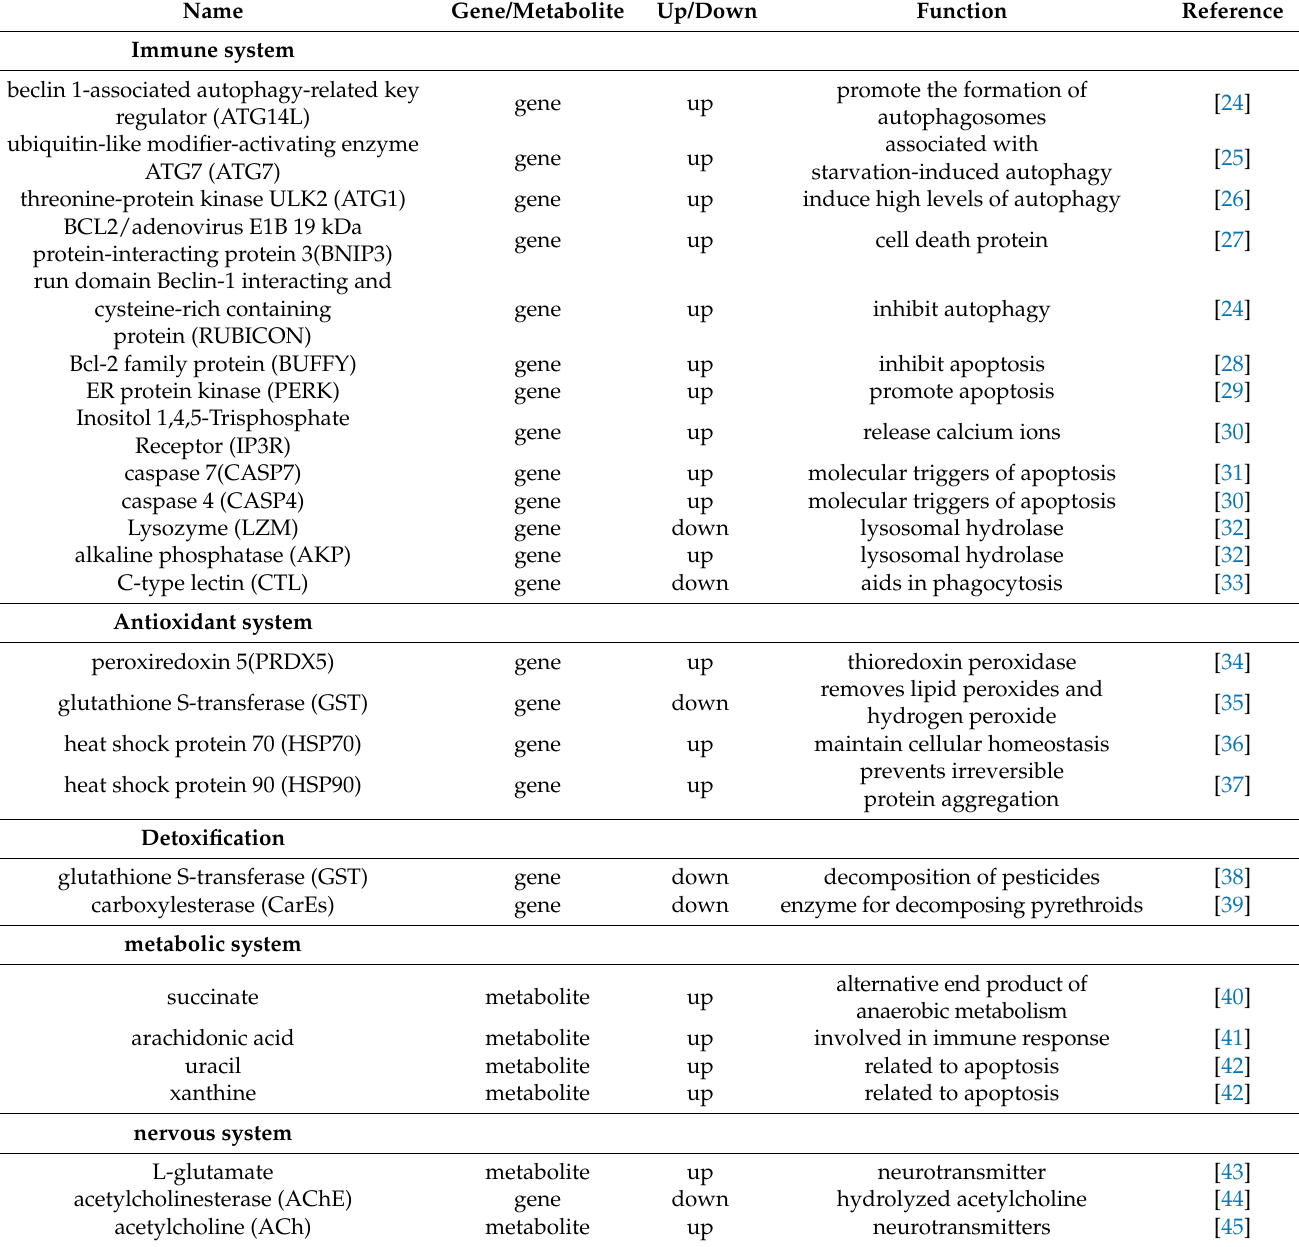
Table 1. Significantly dysregulated genes and metabolites in crabs with